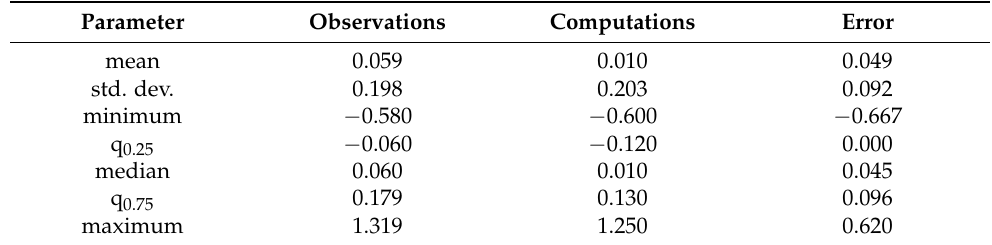
Table 2. The basic statistical characteristics of the observed daily averaged WSE (m a.s.l.) at Tolkmicko and the simulation outcome.